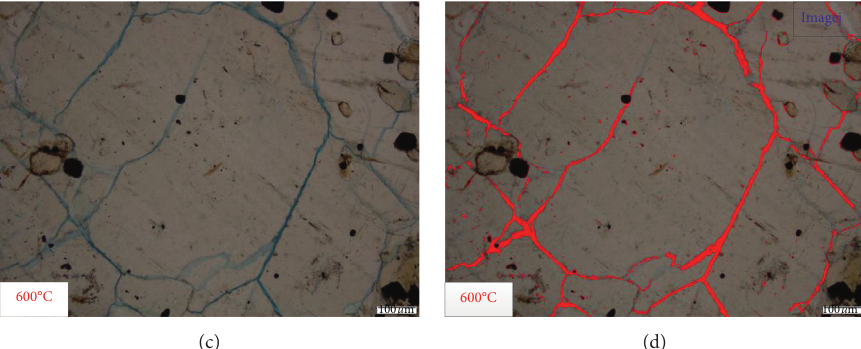
Figure 8: Photomicrographs of thin sections of granite samples (the red in (b) and (d) means that the ImageJ software identifies and counts the blue epoxy resin in diagrams (a) and (c)). (a and b) RT; (c and d) 600 ° C.